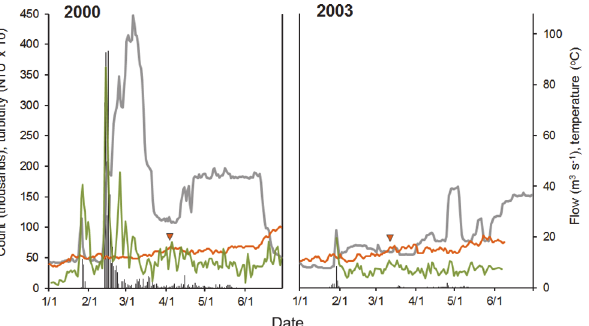
Fig 4. Daily abundance of juvenile salmon outmigrating in 2000 and 2003 relative to ambient environmental conditions. Juvenile salmon were sampled by rotary screw traps at Caswell as they outmigrated from the Stanislaus, and raw counts were expanded into daily abundance estimates (vertical bars) based on trap efficiency models. River flow (grey line) and maximum daily temperature (orange line) were measured at Ripon (data available at http://cdec.water.ca.gov/). Turbidity (green line) was measured at Caswell [40]. The first instance of temperatures reaching 15°C is indicated by an arrow on each